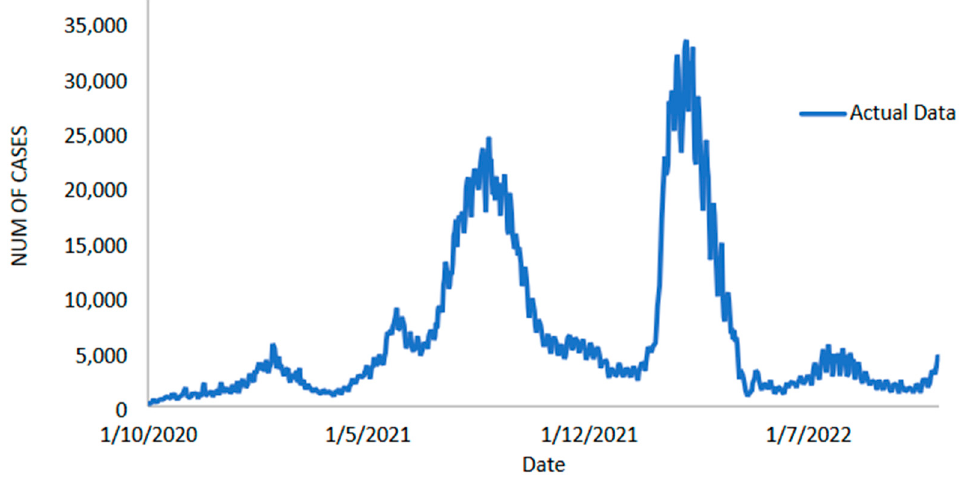
Figure 2. Malaysian daily new positive COVID-19 cases (1 October 2020 to 4 November 2022).